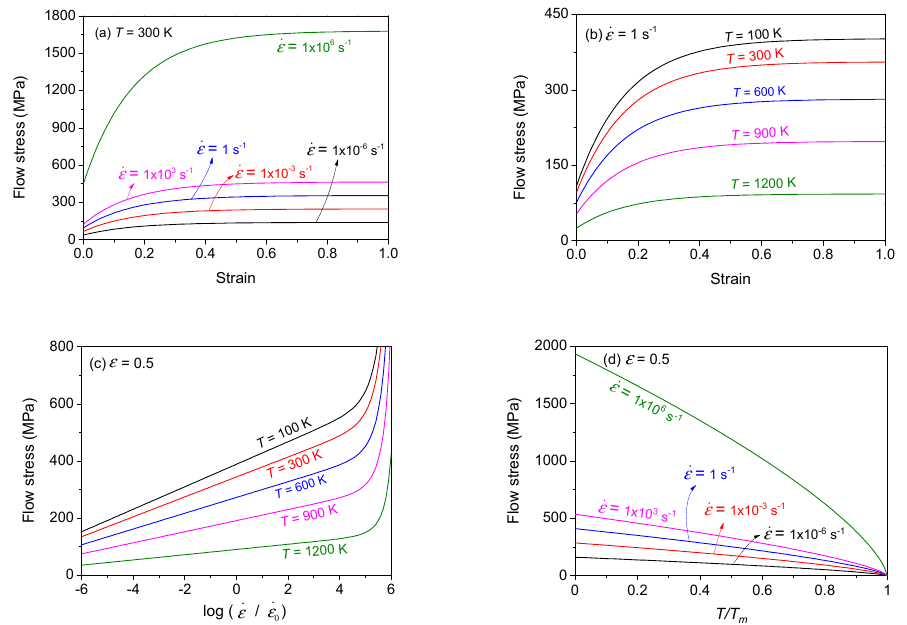
Figure 11. Flow stress–strain curves of OFHC copper predicted using the SK constitutive model ( a ) at 300 K for different strain rates and ( b ) at 𝜀(cid:4662) = 1 for different temperatures. Changes in flow stress at 𝜀 = 0.5 ( c ) with log ( 𝜀(cid:4662) / 𝜀(cid:4662) (cid:2868) ) for different temperatures and ( d ) with T / T m for different strain rates ( T m = 1356 K).